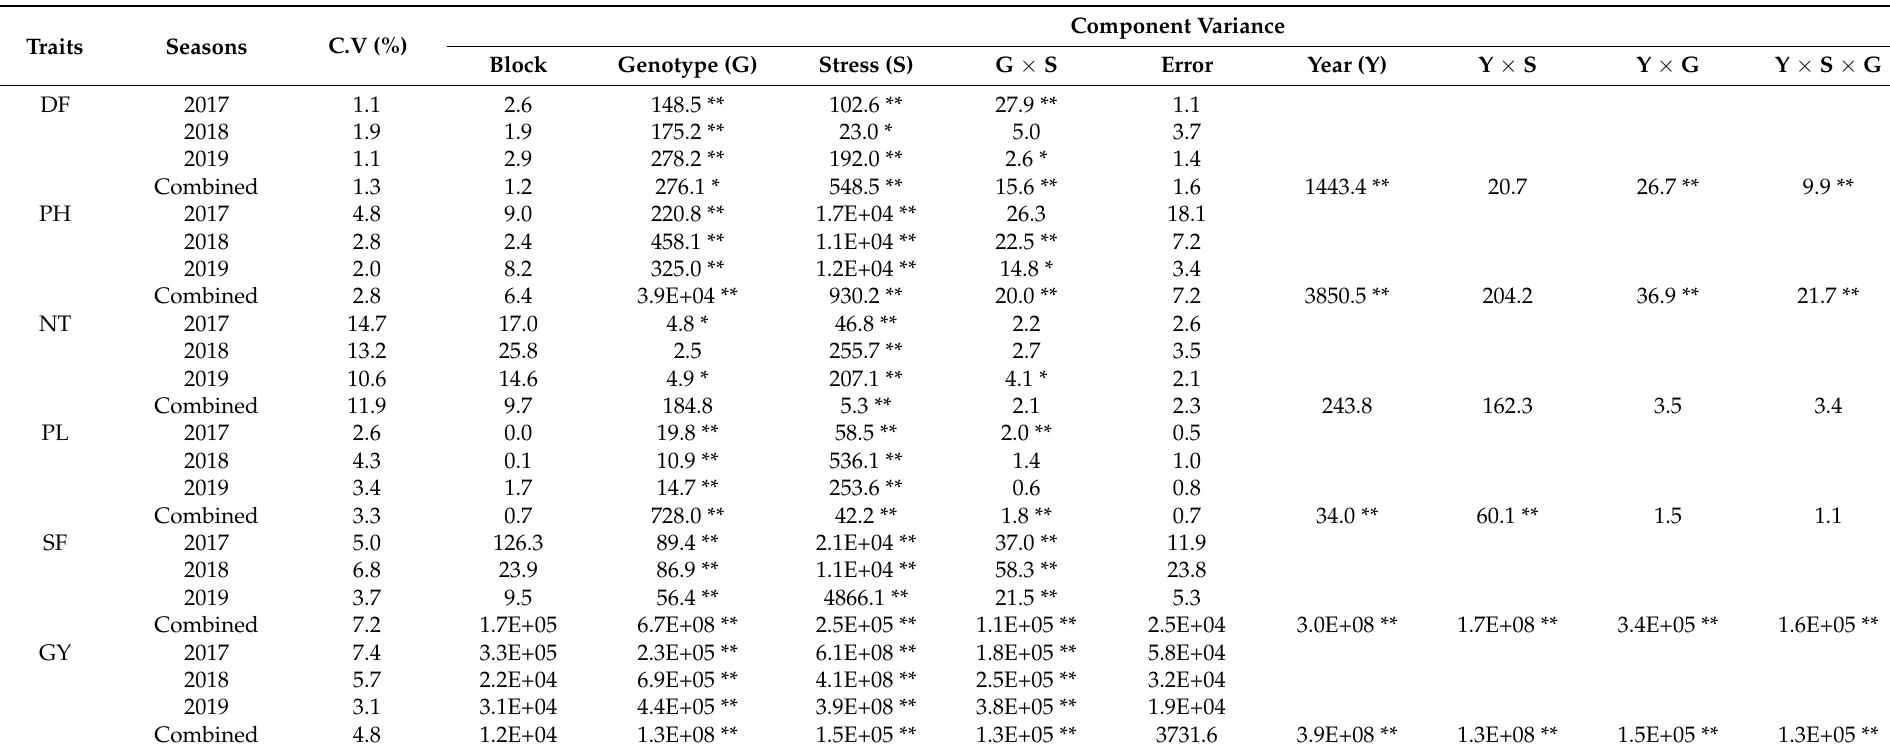
Table 3. Analysis of variance (ANOVA) for agronomic performance of NILs in individual years and combined under two stress treatments, stressed and unstressed. Traits